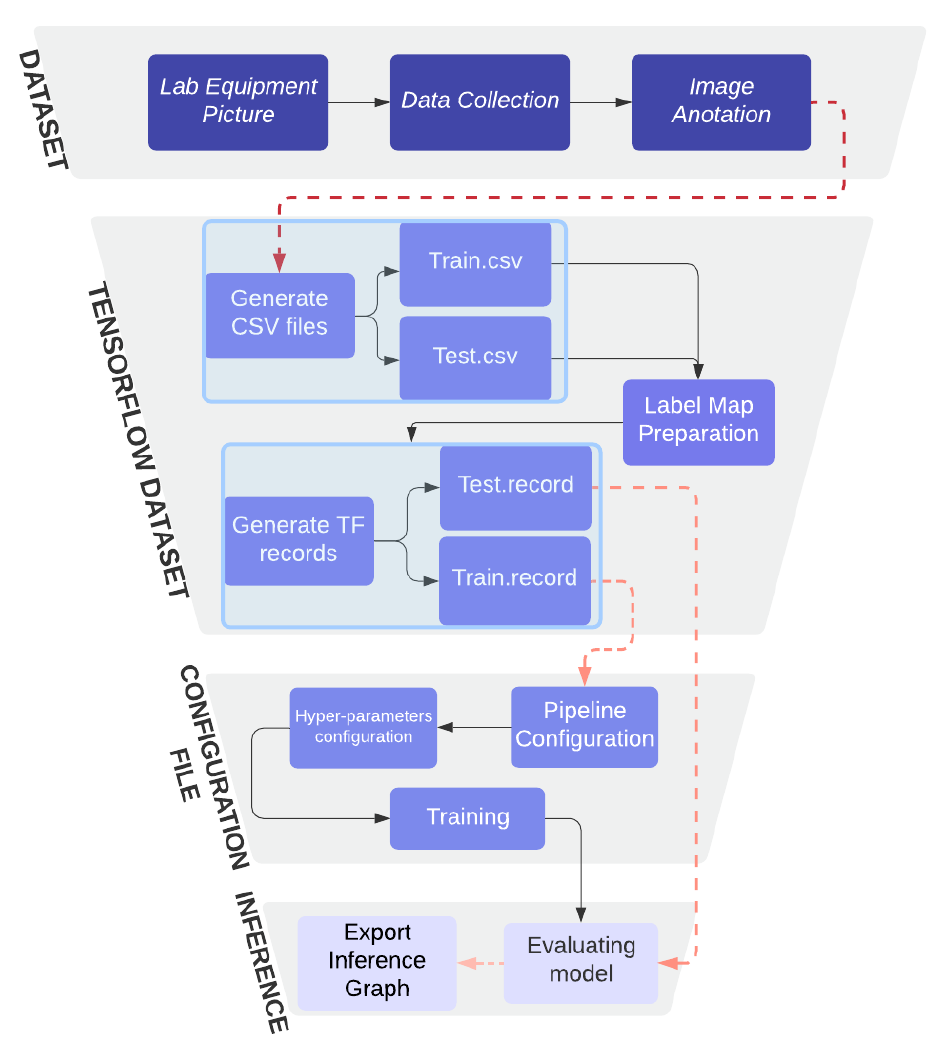
Figure 4. Object detection workflow using TensorFlow